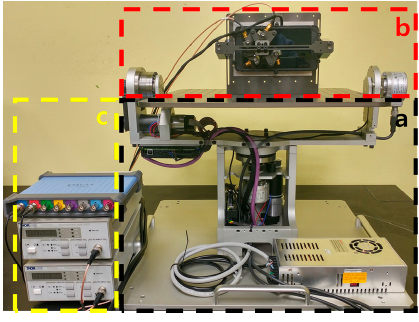
Figure 13. Prototype of the proposed latency measurement system: ( a ) a head position model-based rotary platform, ( b ) a pixel luminance change detector, and ( c ) an oscilloscope and an amplifier.